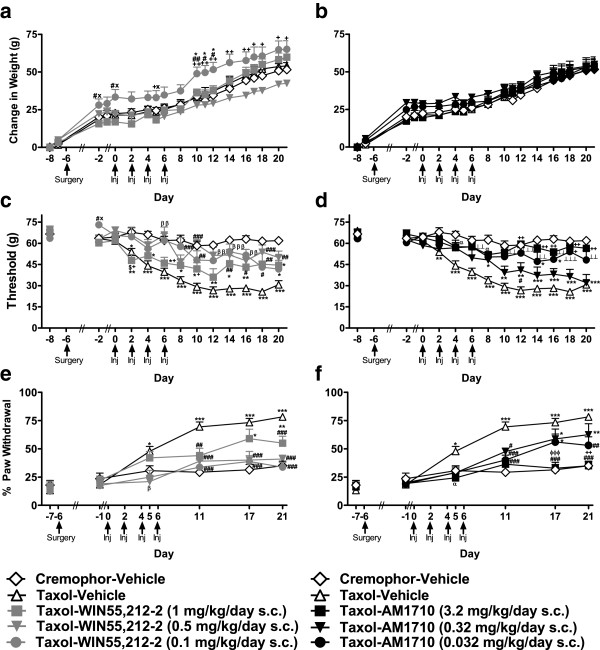
The mixed CB1/CB2 agonist WIN55,212-2 and the CB2-preferring agonist AM1710 suppressed development of paclitaxel-induced mechanical and cold allodynia without significantly altering body weight. a. WIN55,212-2 (0.1 mg/kg/day s.c.) increased whereas b. AM1710 did not alter body weight in paclitaxel-treated animals. Mechanical and cold allodynia were suppressed by WIN55,212-2 (0.1 and 0.5 mg/kg/day s.c.; c. and e., respectively) and AM1710 (0.032 and 3.2 mg/kg/day s.c.; d. and f., respectively). *P < 0.05, **P <0.01, ***P <0.001 vs. Cremophor-Vehicle, #P < 0.05, ##P < 0.01, ###P <0.001 vs. Taxol-Vehicle, xP < 0.05 vs. Taxol-Agonist (high dose), +P < 0.05, ++P < 0.01 vs. Taxol-Agonist (middle dose), $P < 0.05, vs. Taxol-Agonist (low dose), βP < 0.05, ββP < 0.01, βββP < 0.001 Taxol-Agonist (middle and low doses) vs. Taxol-Vehicle,⟂⟂P < 0.01, ⟂⟂⟂P < 0.001 Taxol-Agonist (high and low doses) vs. Taxol-Vehicle, αP < 0.05 Taxol-Agonist (all doses) vs. Taxol-Vehicle, ϕϕϕP <0.001 vs. Taxol-Agonist (middle and low doses). The first drug listed indicates assignment to cremophor or paclitaxel (Taxol) treatment. The second drug indicates drug administered via osmotic mini pump chronic infusion. Day numbers reference days post-chemotherapeutic treatment (i.e., negative days indicate days prior to chemotherapeutic treatment). Surgery indicates the day (day -6) on which osmotic mini pumps were implanted subcutaneously. (ANOVA; Dunnett and Tukey post-hoc tests). N = 8–18 per group.